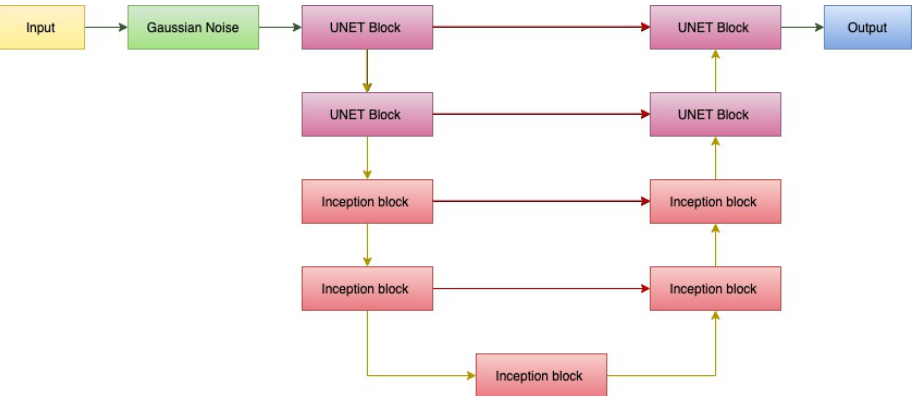
Figure 11. Third proposed architecture: Hybrid recurrent-inception UNET.